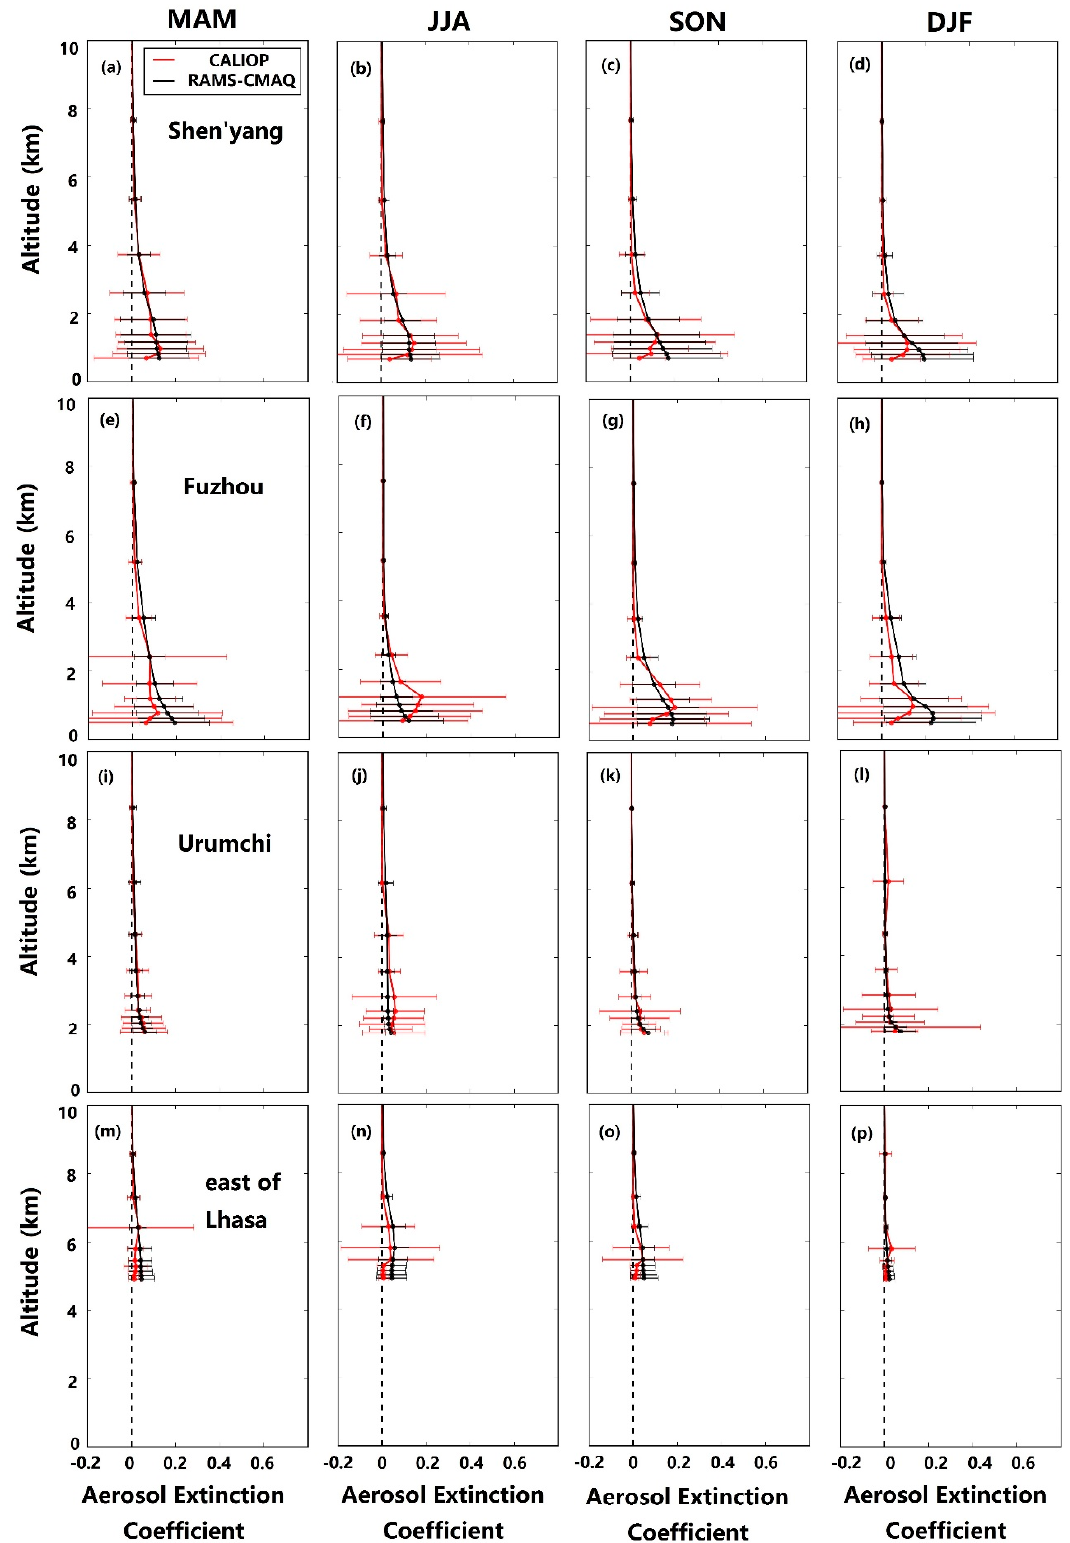
Figure 6. Comparison of the CALIOP measured and RAMS-CMAQ simulated AEC profiles (unit: km − 1 ) in 550 nm wavelength for four seasons and locations: ( a – d ) Shenyang; ( e – h ) Fuzhou; ( i – l ) Urumchi; ( m – p ) and east of Lhasa. The horizontal red bars indicate + σ (SDV) of the CALIOP-derived AEC. The black bars indicate + σ (SDV) of the RAMS-CMAQ-simulated